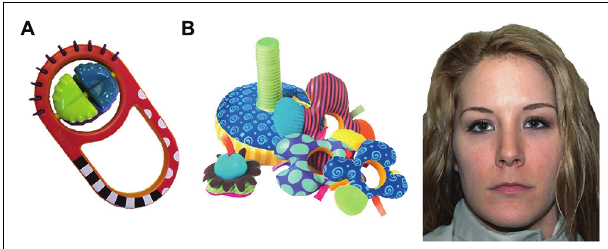
FIGURE 2 | Examples of toy used during reaching assessment (A), and of stimuli used during face preference task (B).